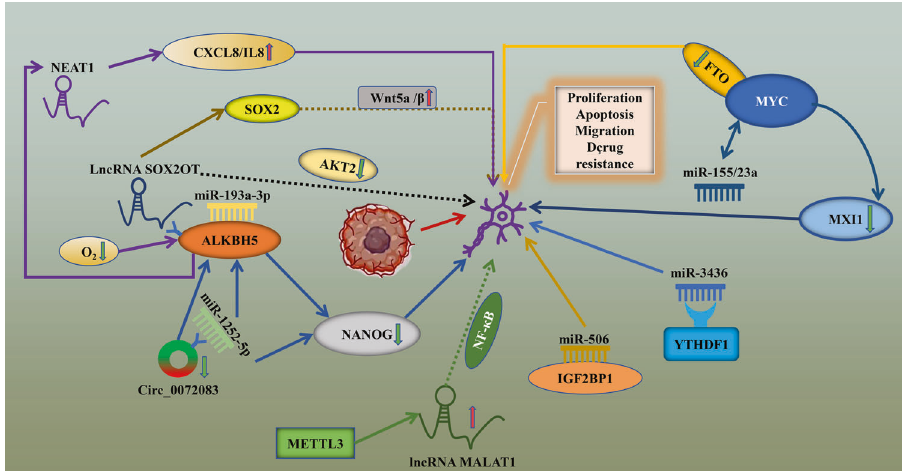
Fig. 3 Schematic diagram of mutual targeting regulation of m6a regulators and ncRNAs in glioma. m6A regulators can interact with ncRNAs and affect the biological behavior of glioma cells, such as proliferation and